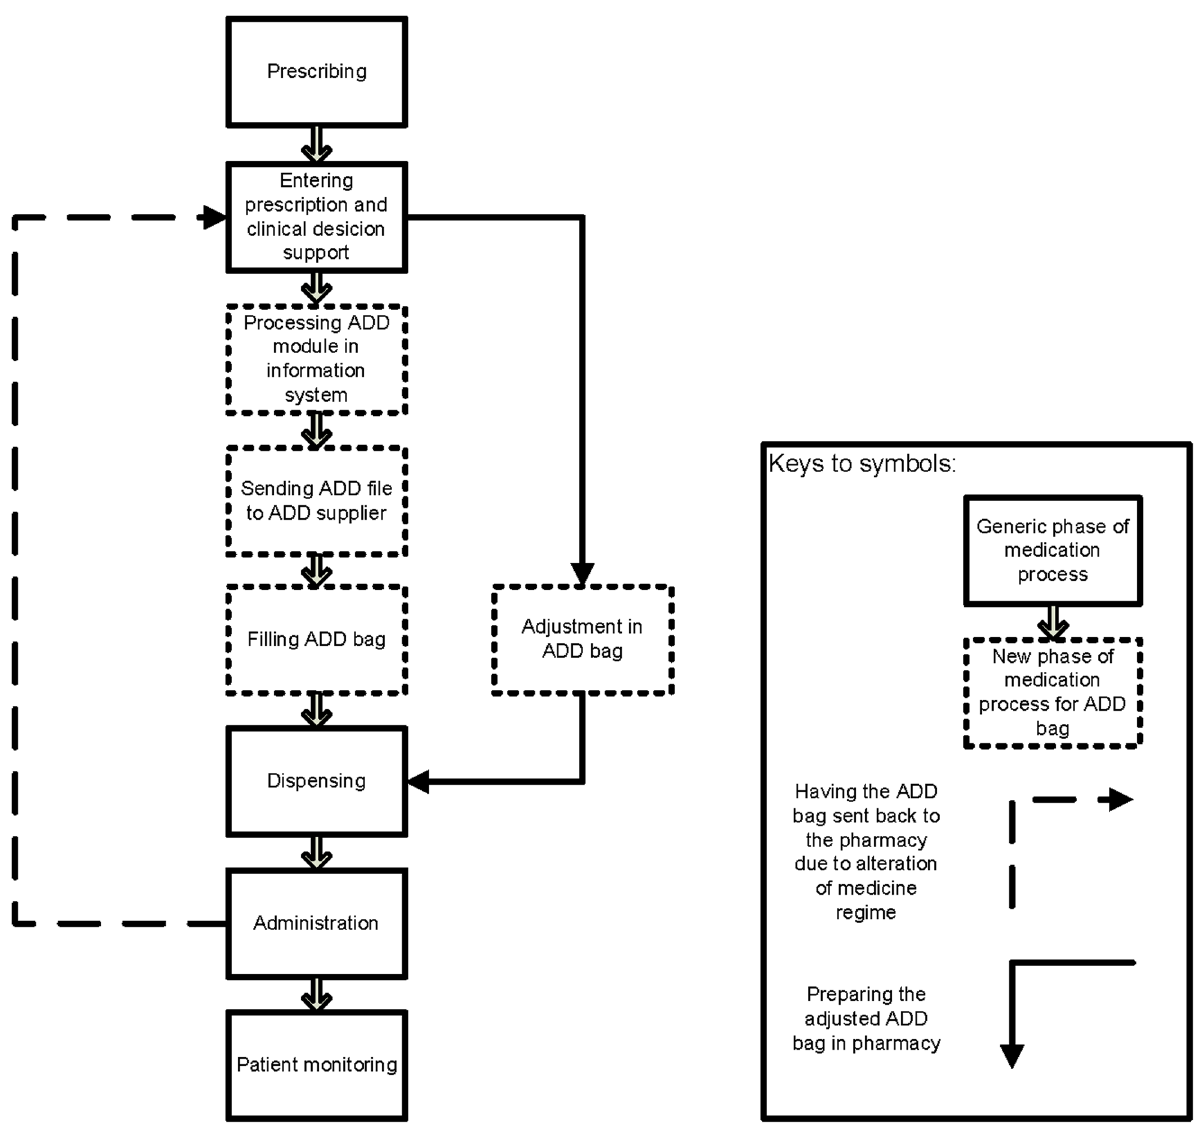
Figure 1. Scheme of the ADD process.